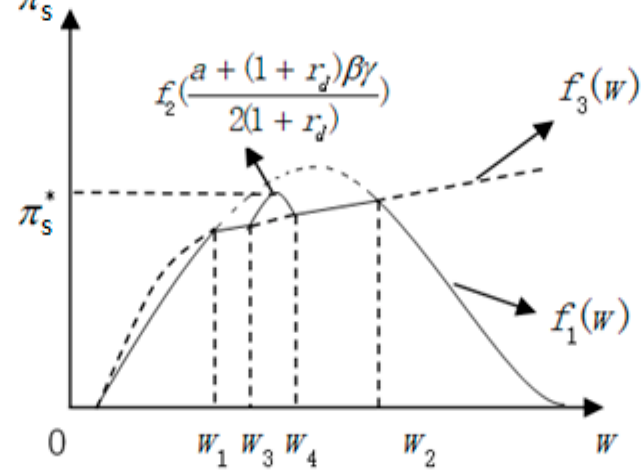
Figure A2. The schematic profit function of the supplier for Case A6.